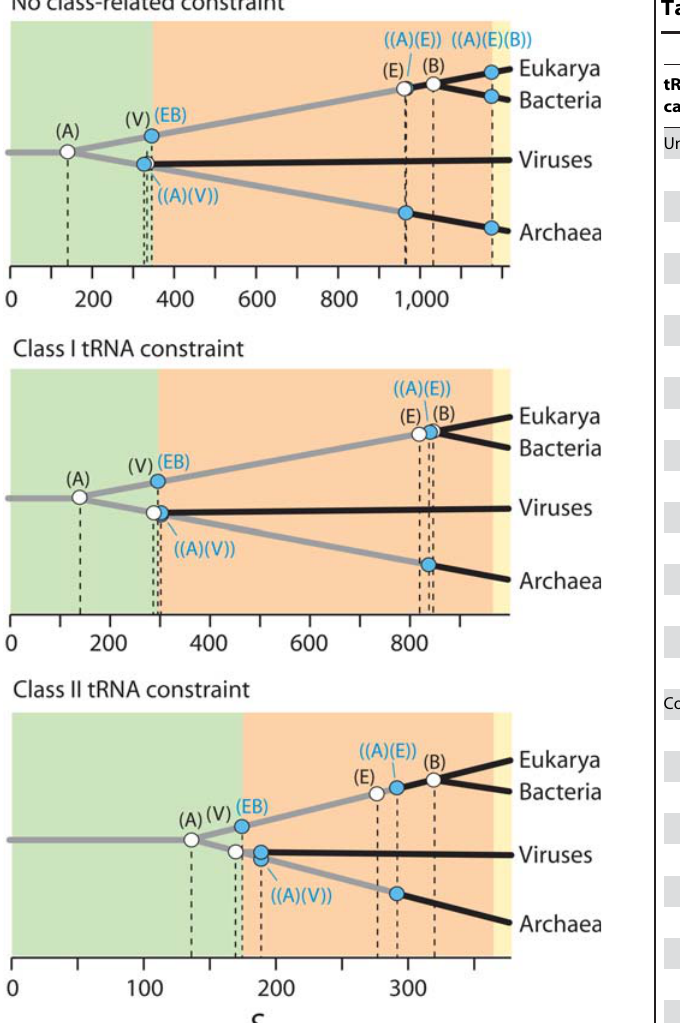
Table 2. Origins of the viral world